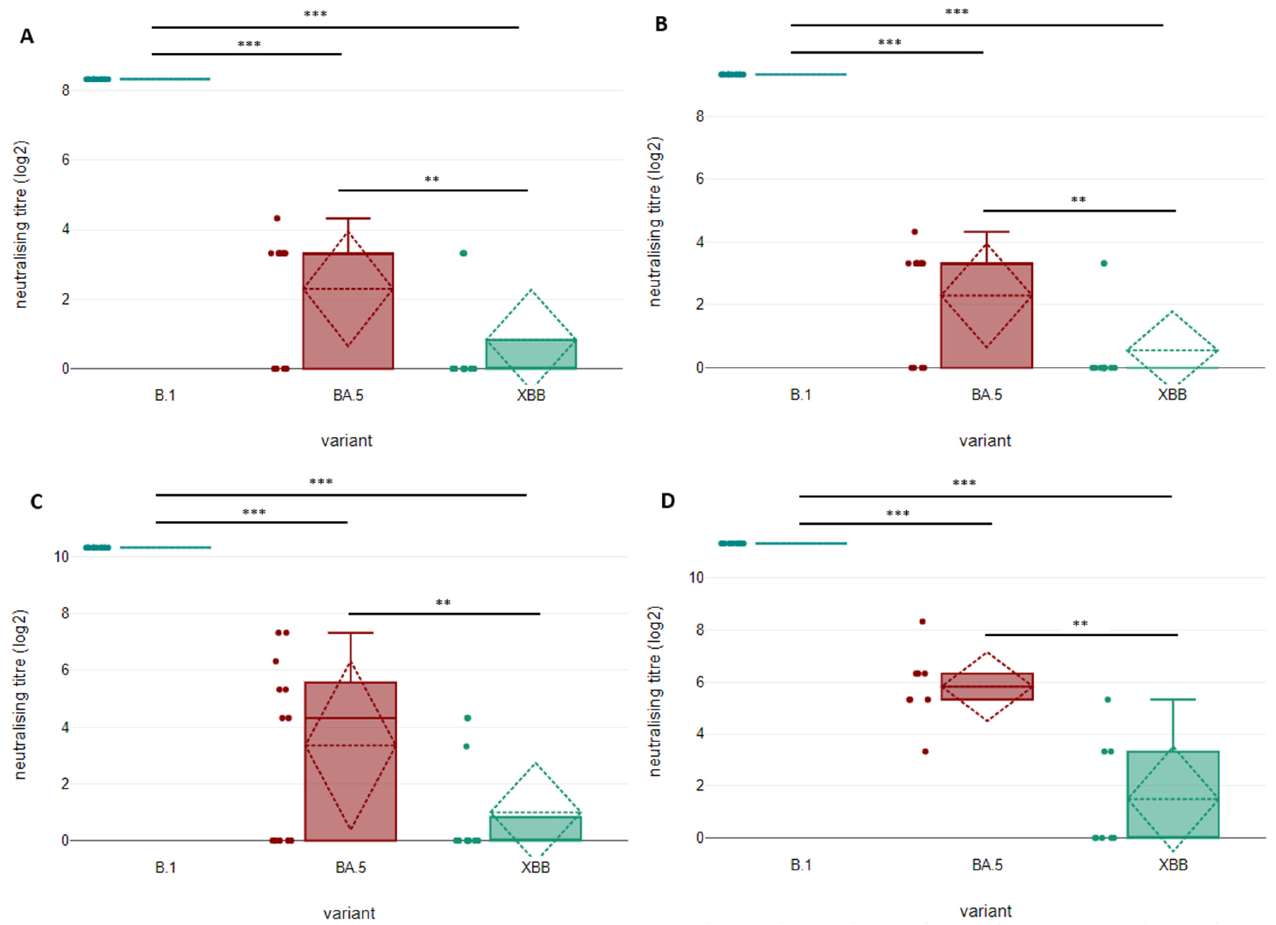
Figure 2. Comparison of neutralising antibody titres of highly neutralising sera (titres 320, 640, 1280 and 2560) against SARS-CoV-2 original strain B.1, lineage B.1.1.529 BA.5 and recombinant XBB at four weeks after the second dose of BNT162b2 vaccine. For the groups of sera with titres of 320, 640 and 1280, a total of 12 samples were tested ( n = 12), while for the group of sera with a titre of 2560, only 8 samples were included ( n = 8). Results for sera with a neutralisation titre of 320, 640, 1280 and 2560 are shown in panels ( A ), ( B ), ( C ) and ( D ), respectively. The detection limit of the assay is defined as a titre of 10; sera which did not reach the detection limit were considered negative and their titre was approximated to zero. The upper limit of detection is defined as a titre of 5120. Statistical comparison of neutralisation titres against the three considered viral variants were compared using a one-way repeated-measures ANOVA test (*** p < 0.01, ** p < 0.05). Medians are indicated with solid horizontal lines, means with dashed horizontal lines and standard deviations with dashed oblique